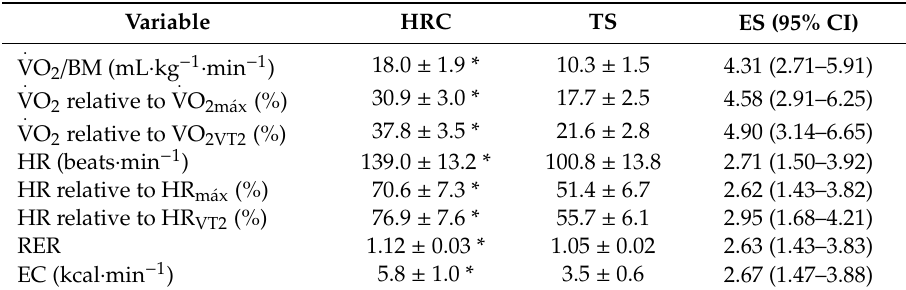
Table 2. Values of cardiorespiratory parameters in each training session (mean ± SD).